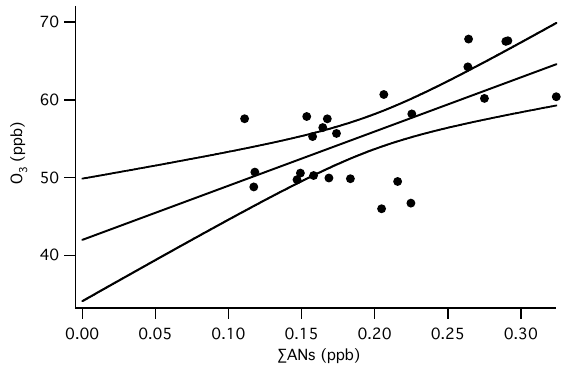
Fig. 6. Correlation plot of measured ambient O 3 vs. 6 ANs, for the ≈ 6days during the campaign when the TD-LIF was running in “3-gas” ambient mode, with standard linear regression including 95% confidence limits, slope = 70 ± 38. Only data from 12 noon– 6p . m . LT are used (see